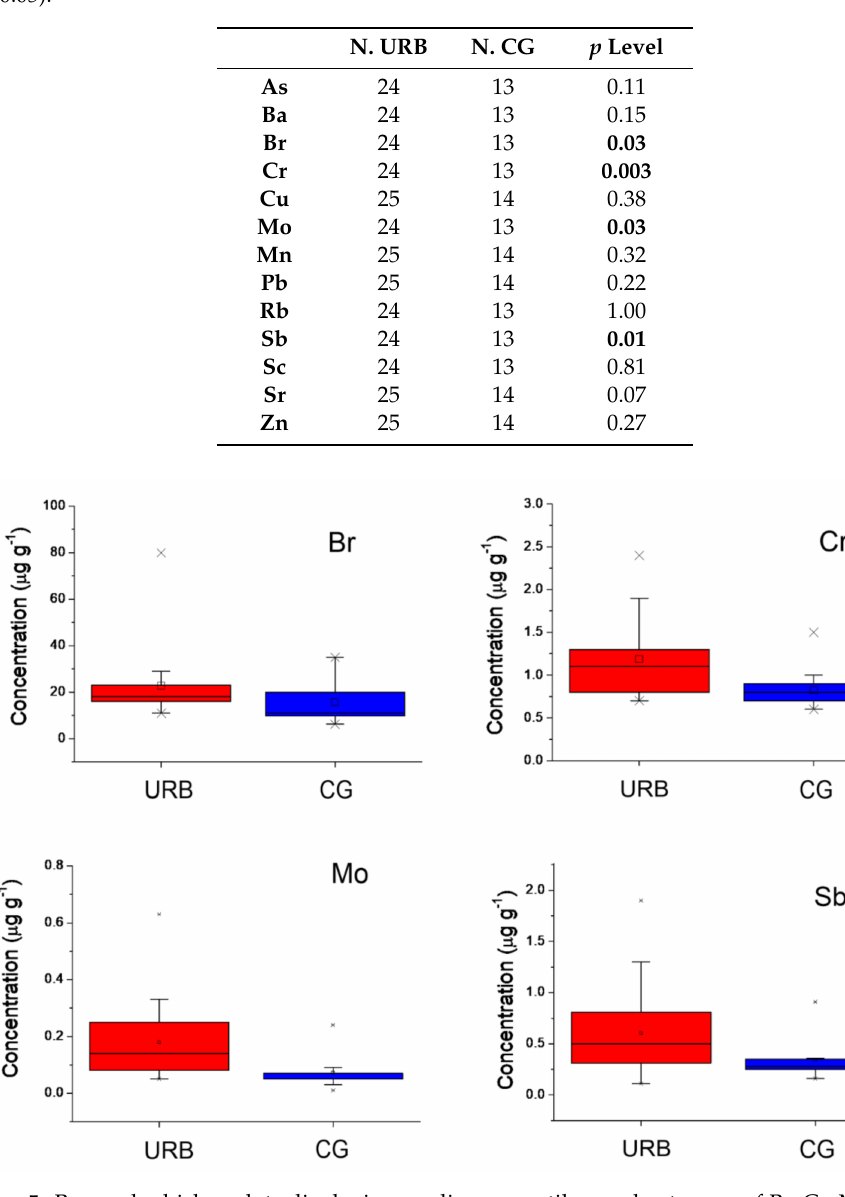
Figure 5. Box and whisker plots displaying medians, quartiles, and extremes of Br, Cr, Mo, and Sb concentrations in Ficus macrophylla samples. Box interquartile ranges (25–75%) with median indication are shown by solid lines; vertical lines outside the box (whiskers) indicate the range (1–99%) between the highest and lowest observations, excluding the minimum and maximum. Data are given in µ g g − 1 (dry